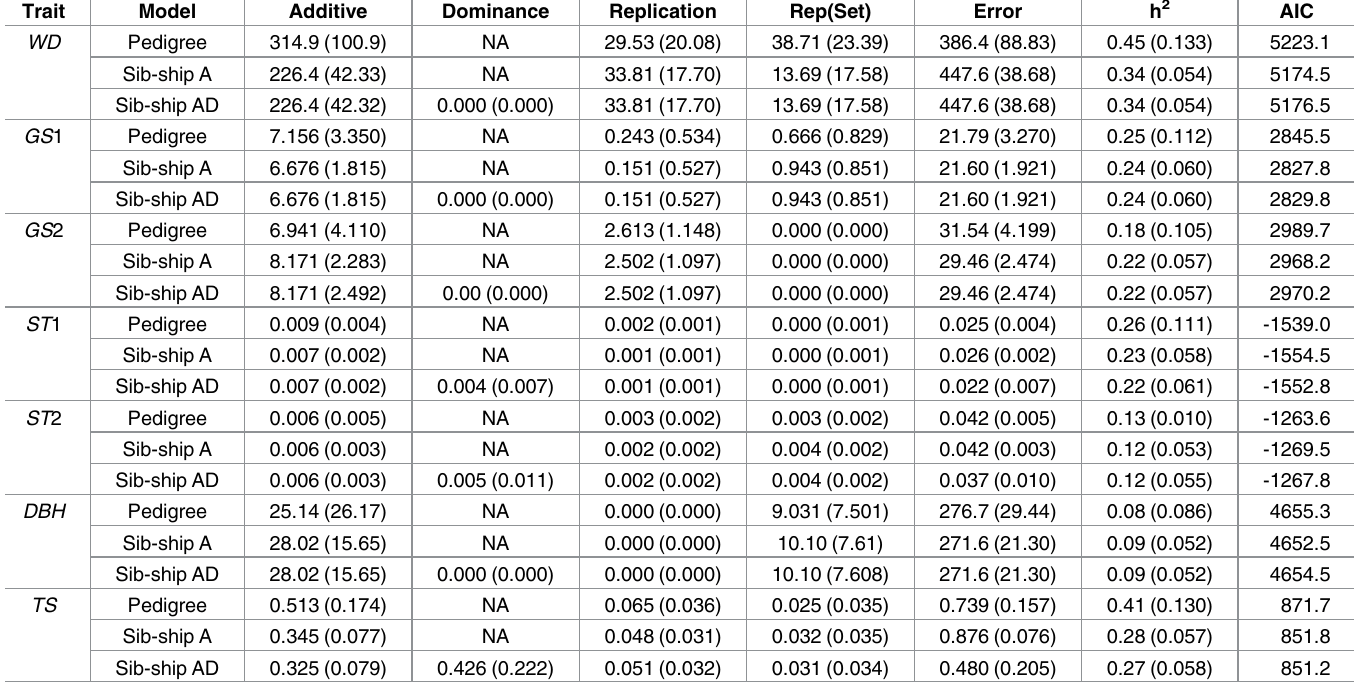
Table 1. Variance components, heritability, their standard errors and Akaike Information Criterion (AIC) estimated on the basis of pedigree infor- mation, sib-ship reconstruction using only additive relationship matrix (Sib-ship A) and sib-ship reconstruction using additive and dominant rela- tionship matrix (Sib-ship